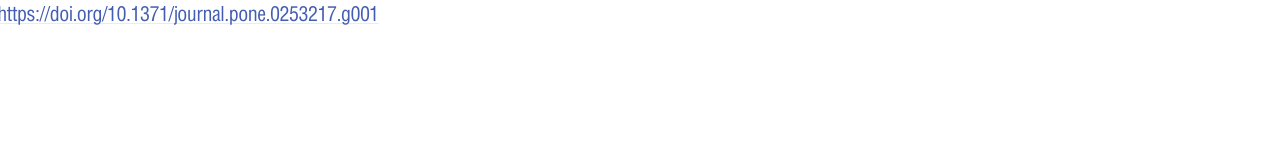
PLOS ONE | https://doi.org/10.1371/journal.pone.0253217 July 1,